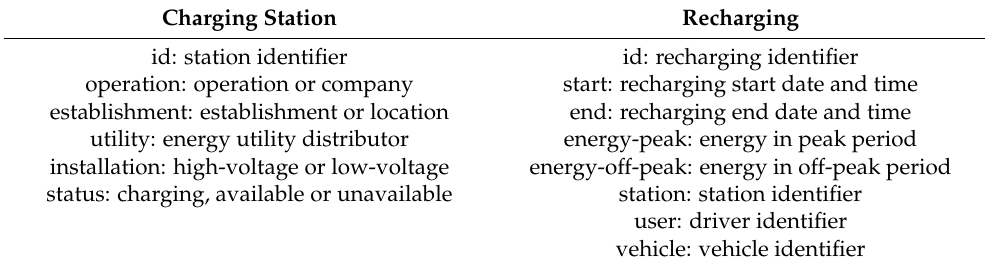
Table 1. Internal data attributes.